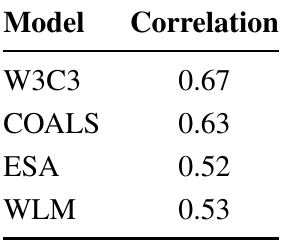
Table 8. Pearson correlations with MCSM (N =